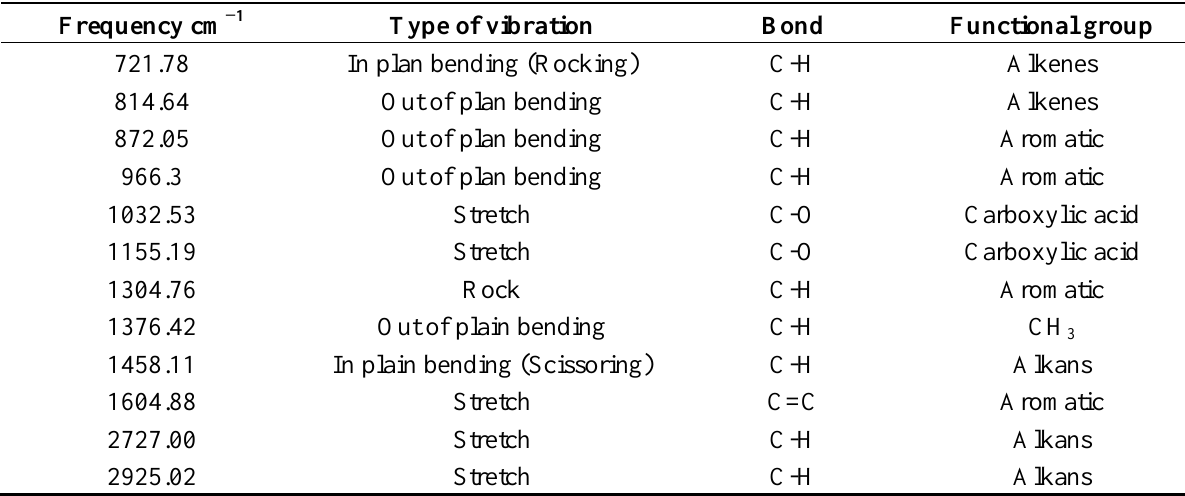
Table 12. Results of analysis of the recycled oil (base oil only before adding the additives) by acetic acid-vacuum distillation-clay